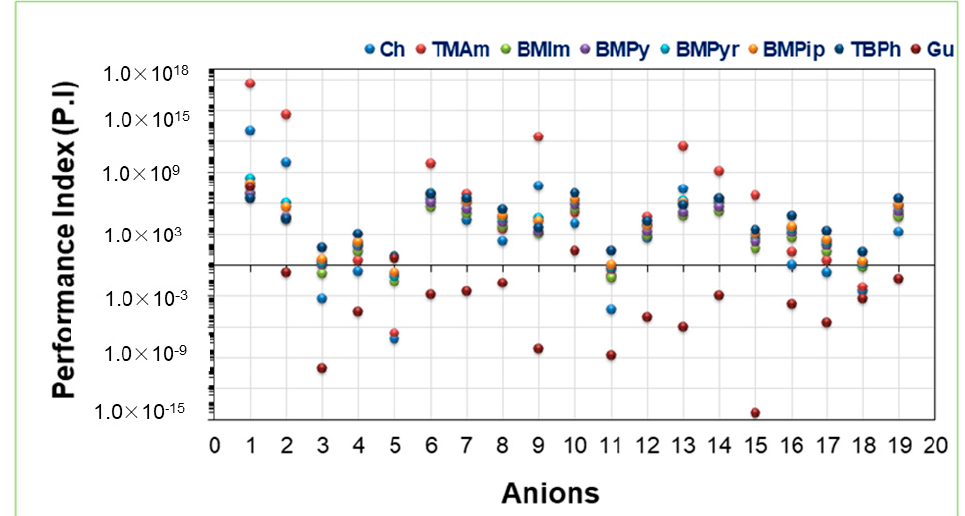
Figure 6. Performance index of the studied ILs for Ibf.